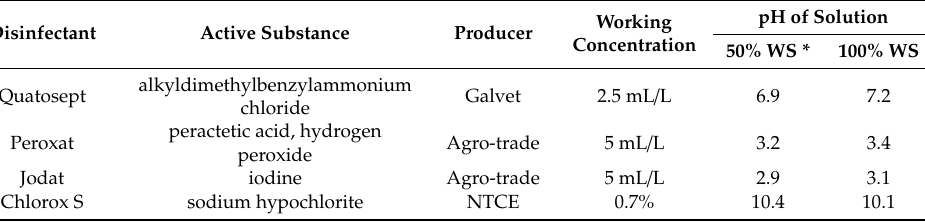
Table 9. Characteristic of disinfectants used in the